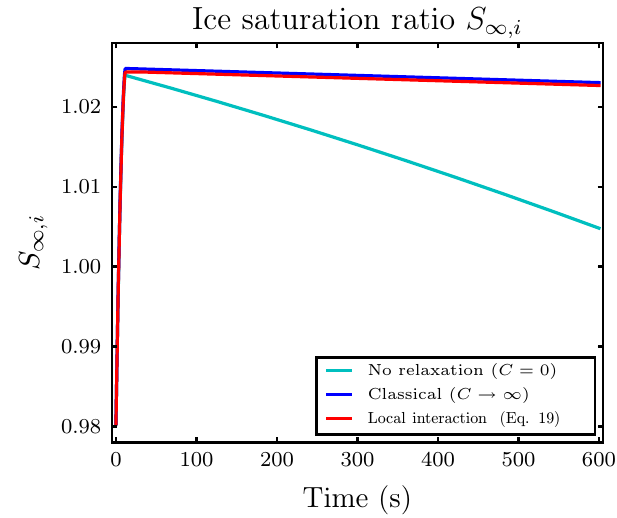
Figure B1. Temporal evolution of saturation ratio S ∞ , i with respect to ice for the same simulation as in the upper row in Fig.